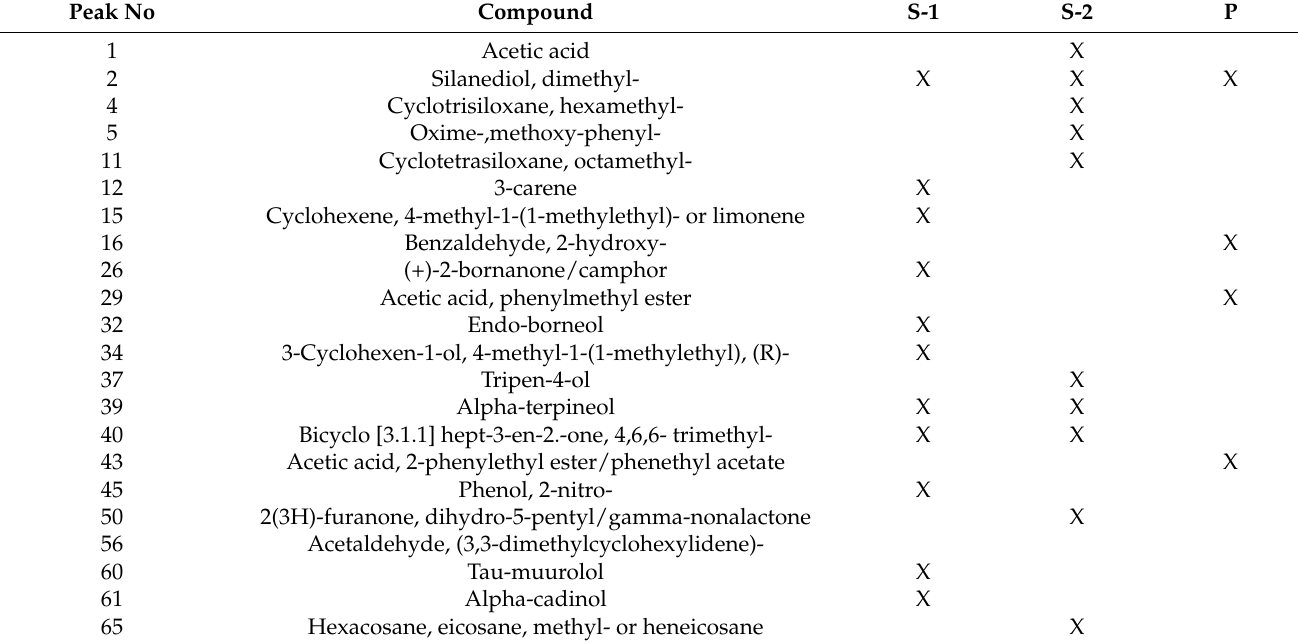
Table 4. Chemical compounds detected by gas chromatography–mass spectrometry (GC–MS) for spruce-based (S-1 and S-2) and poplar-based (P) press